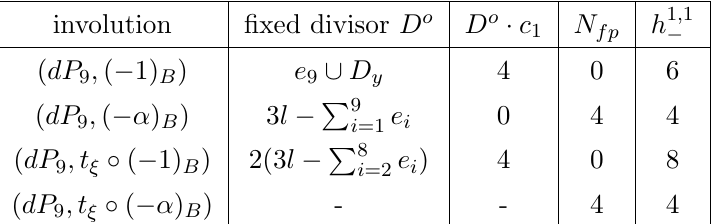
, its intersection with the 1